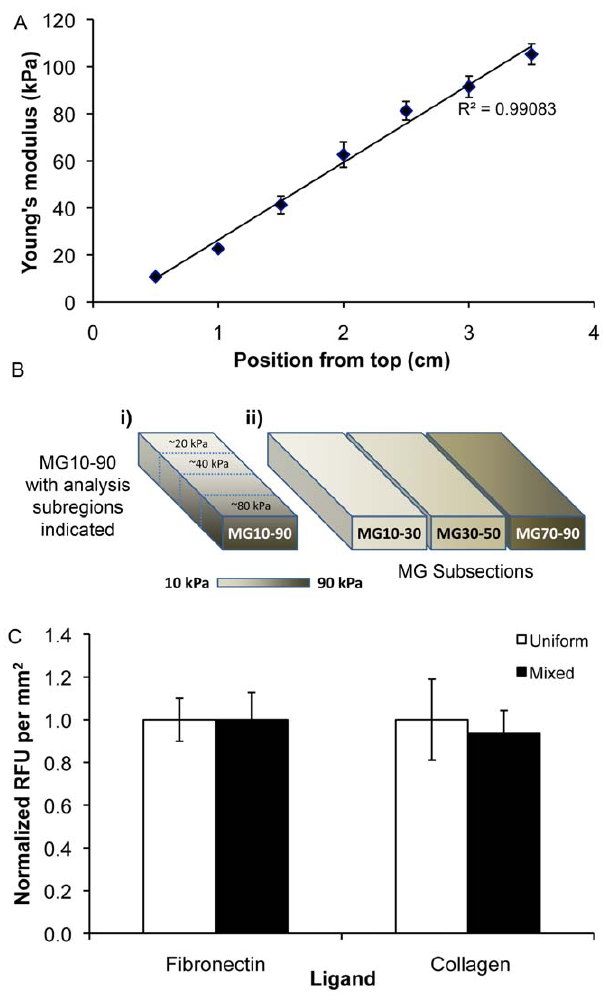
Figure 1. Characterization of cell culture interface. (A) The substrate compliance was measured in 0.5 cm increments using spherical indentation testing. Compliance was a linear function of longitudinal position. (B) Schematic representation of (i) MG10–90 broad gradient substrates with outlined subregions representing those analyzed after culture and (ii) narrow gradient subsection substrates. (C) Immunosorbance techniques were used to measure the bioactivity of substrates functionalized with fibronectin, collagen, or a mixed ligand solution of both. Activity was relatively similar between the uniform and mixed ligand